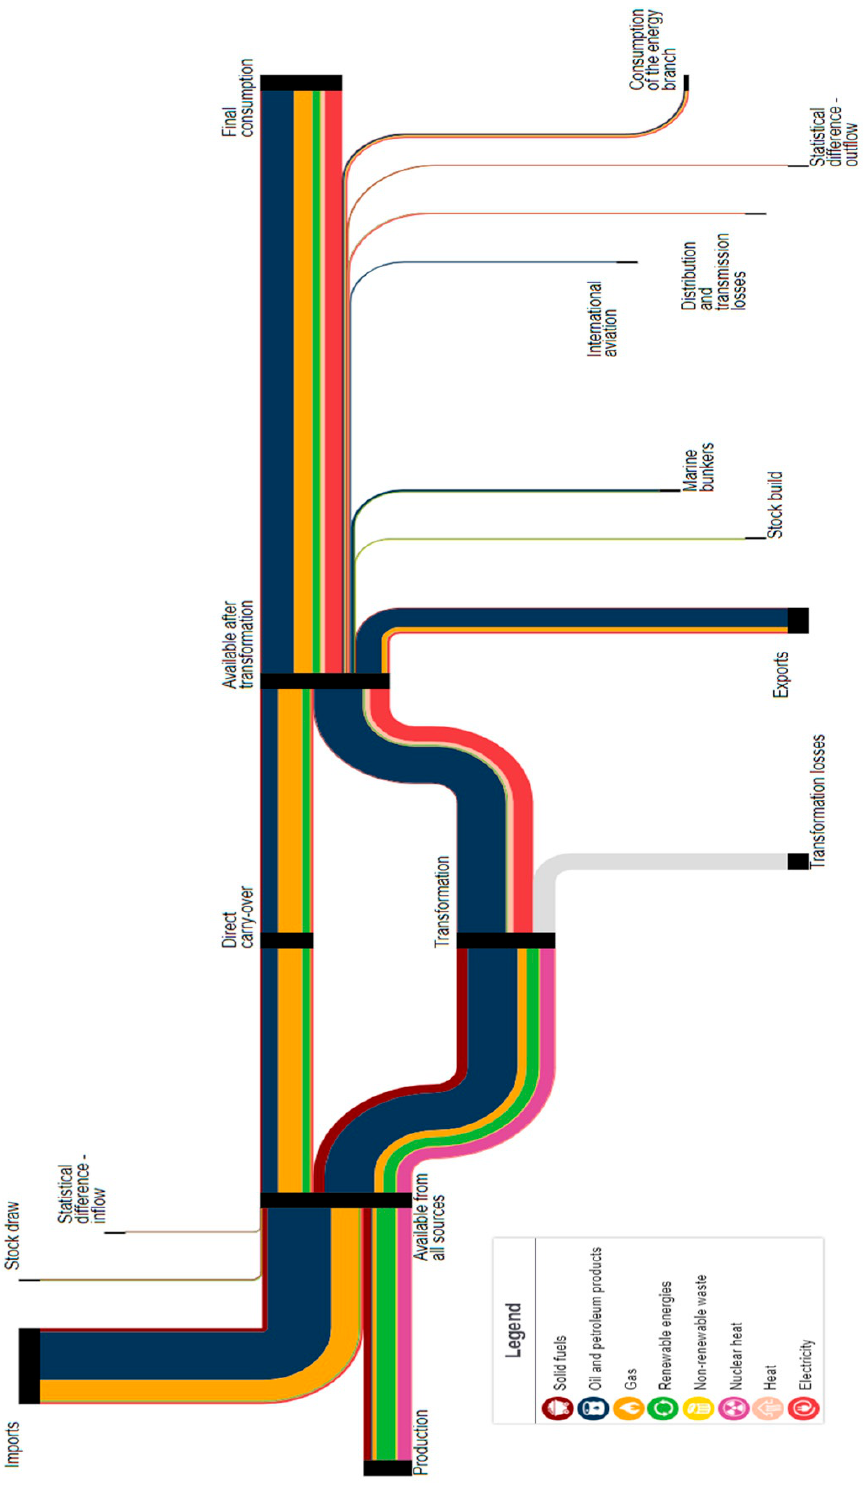
Figure A1. The Eurostat’s Sankey Diagram, 2020 (source: The European Commission website, Eurostat (ec.europa.eu/eurostat/cache/sankey/energy/sankey.html, accessed on 17 August 2022); © European Union, 1995–2022).